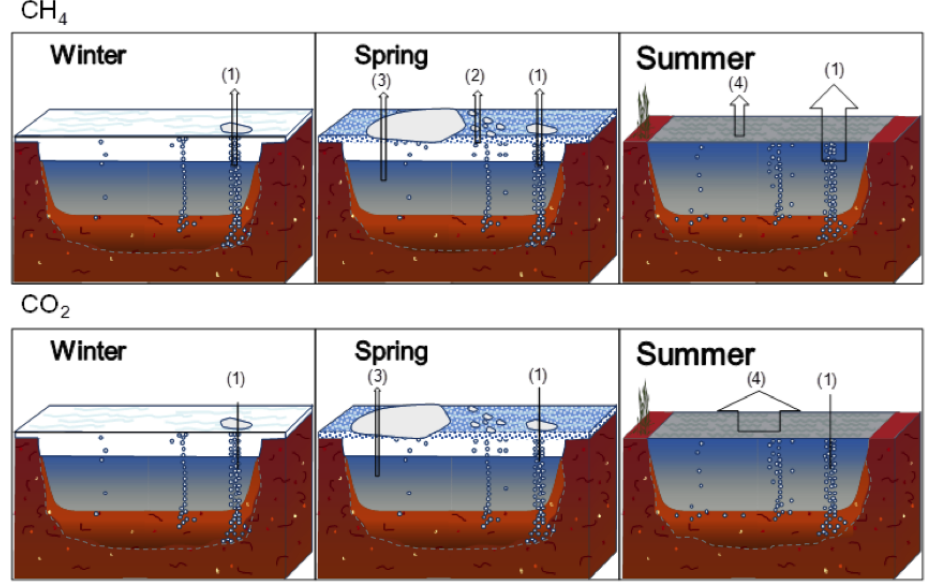
Figure 5. Schematic of CH 4 and CO 2 emission pathways during different seasons in thermokarst lakes. The thickness of arrows indicates the relative magnitude of contribution from each pathway according to a study of 40 Alaskan lakes (Sepulveda-Jauregui et al., 2015): (1) direct ebullition through ice-free hotspot seeps in winter and from all seep classes during the last month of ice cover in spring and in summer; (2) ice-bubble storage emission during spring ice melt; (3) storage emission of dissolved gases accumulated under lake ice when ice melts in spring; (4) diffusion emission from open water in summer. The background ebullition mode, discussed in the text, is not shown. The dashed line indicates the boundary between the thaw bulb under lakes and the surrounding permafrost. Figure modified from Sepulveda-Jauregui et al.,